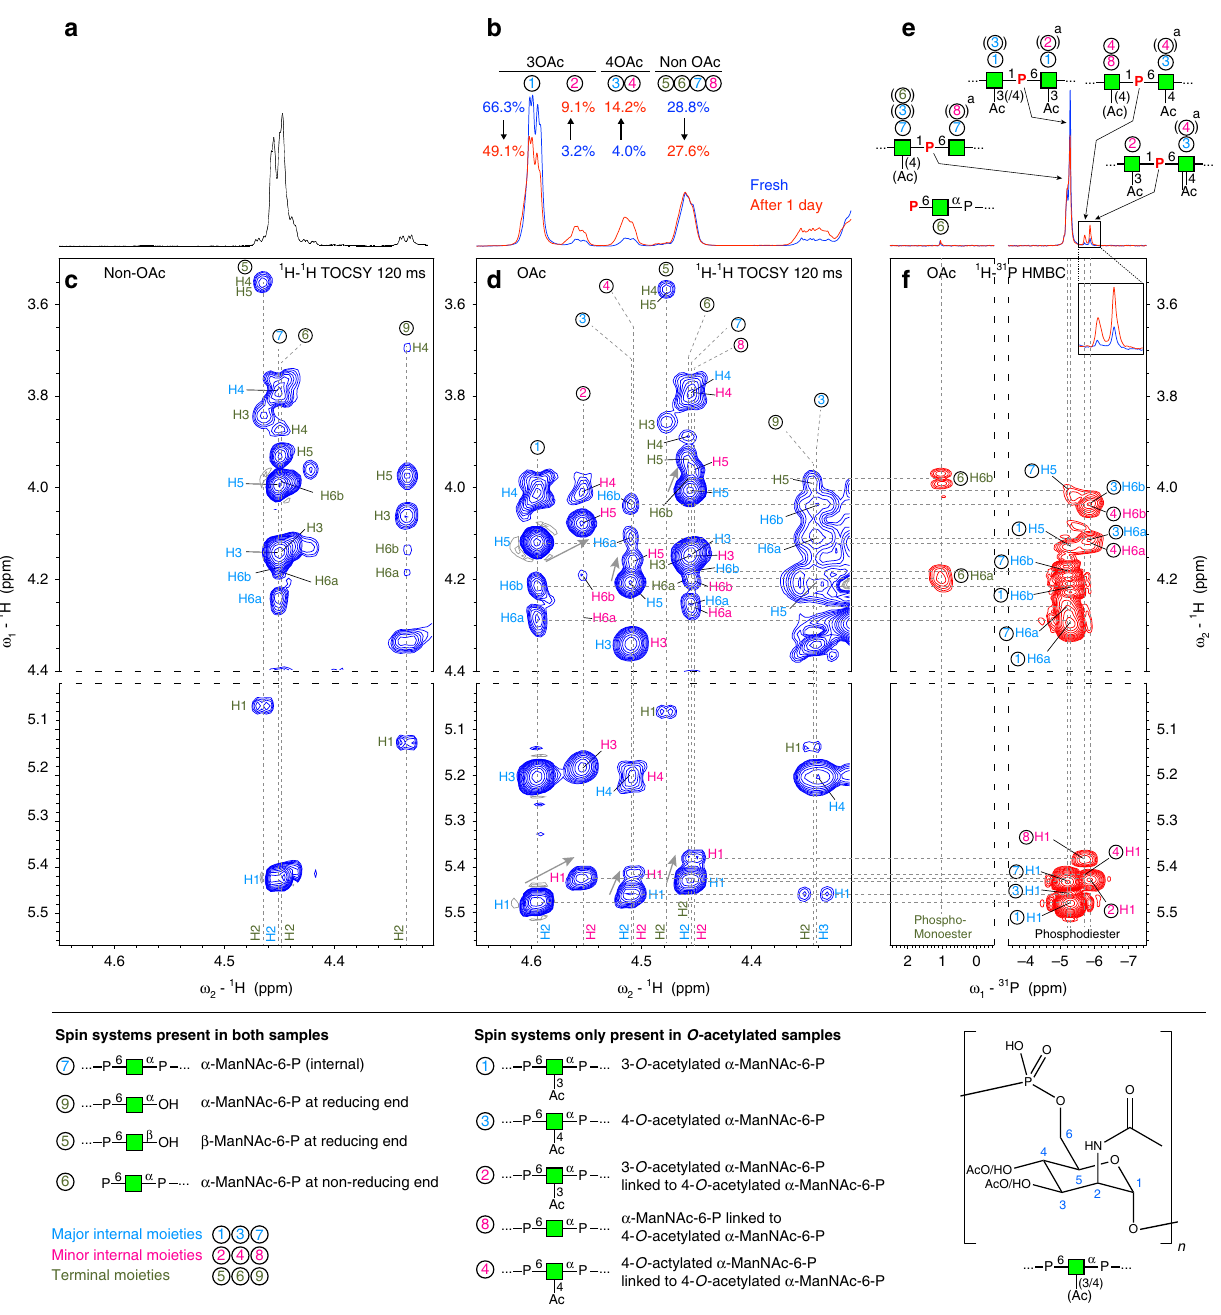
Fig. 2 Comprehensive NMR analysis of O -acetylated and non- O -acetylated serogroup A polymer. a , b 1 H NMR spectra of non- O -acetylated ( a ) and O -acetylated ( b ) serogroup A capsule polymer. b Freshly puri fi ed O -acetylated polymer (blue) was incubated at 45 °C and pH 7 for one day (red), leading to a shift in O -acetylation from C3 to C4. c , d 2D 1 H- 1 H TOCSY (total correlation spectroscopy) spectra showing the H2 signal of each spin system on the ω 2 axis and the correlations between H2 and the other ManNAc protons on the ω 1 axis. Four spin systems were identi fi ed in the non- O -acetylated sample ( c ) and nine in the O -acetylated sample ( d ). The identi fi ed spin systems were labeled 1 to 9 , with the most down fi eld spin system labeled 1 and the most up fi eld labeled 9 . e 31 P NMR of O -acetylated polymer. a indicates spin systems that belong to moieties, which cannot be excluded as connecting residue. f 1 H- 31 P HMBC spectrum corresponding to the 1D 31 P spectrum shown in e